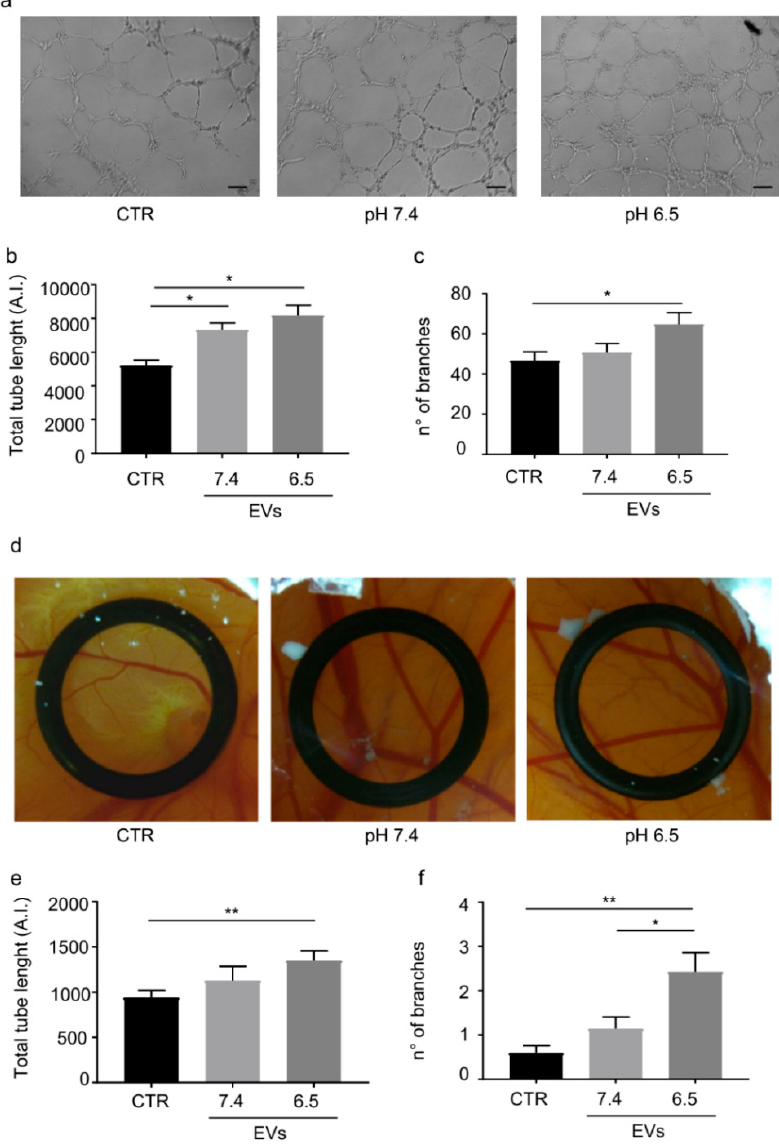
Figure 3. OS-derived EVs promoted significantly tube formation by HUVEC cells in vitro and new blood vessel growth on the chorioallantoic membrane (CAM) vascular bed. ( a ) Representative images of HUVEC cells on matrigel in presence of OS-derived EVs (scale bar = 100 µm) (10× objective; 100 magnification). ( b ) The treatment with EVs derived from OS maintained at acidic and neutral pH significantly increased the total tube length in vitro (AI: arbitrary unit; mean ± SE, p = 0.034 for CTR versus pH 7.4 and for CTR vs. pH 6.5, n = 4, Mann–Whitney test). ( c ) The number of branches was increased by the treatment with EVs isolated by OS maintained at acidic pH (mean ± SE, p = 0.05, n = 4, Mann–Whitney test). ( d ) CAM: representative images of new blood vessel growth after the treatment with OS-derived EVs. ( e ) Quantitative analysis of the total tube length revealed that EVs derived from OS cells maintained at acidic pH induced vessel growth (AI: arbitrary unit) (mean ± SE, p = 0.0018, n = 7, Mann–Whitney test). ( f ) The number of vessels junction is significantly increased by EVs obtained from OS cells maintained at acidic pH (mean ± SE, p = 0.0026, n = 7, Mann–Whitney test). * p value < 0.05; ** p value <